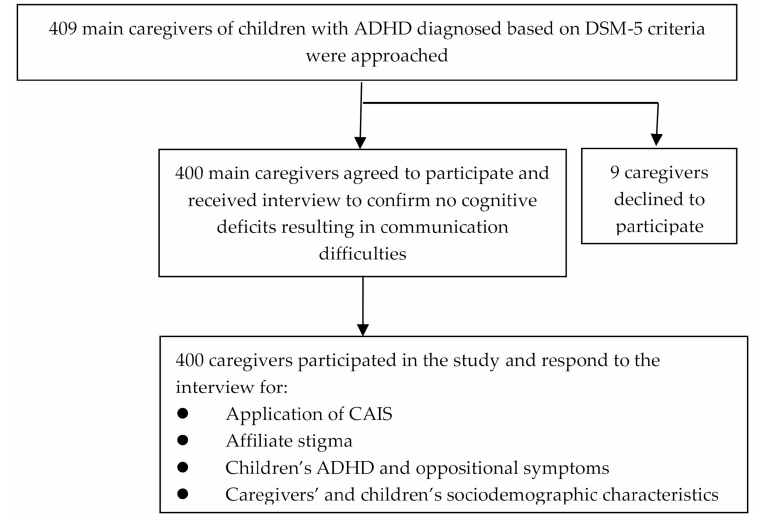
Figure 1. Flowchart of study design. ADHD: Attention-deficit / hyperactivity disorder; CAIS: Complementary and alternative intervention strategies; DSM-5: Diagnostic and Statistical Manual of Mental Disorders, Fifth